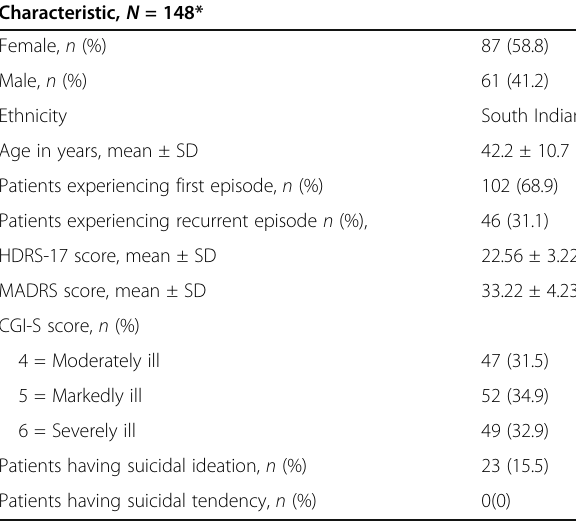
Table 1 Baseline demographic and clinical characteristics of